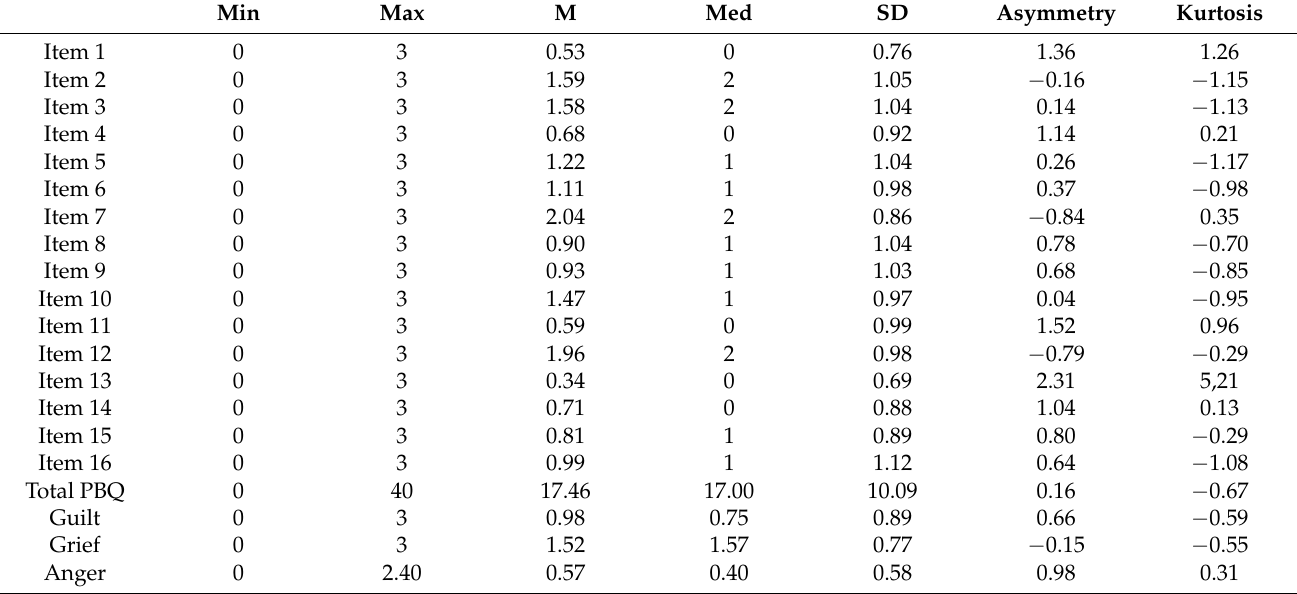
Table 1. Descriptive analysis of the values obtained in the PBQ.